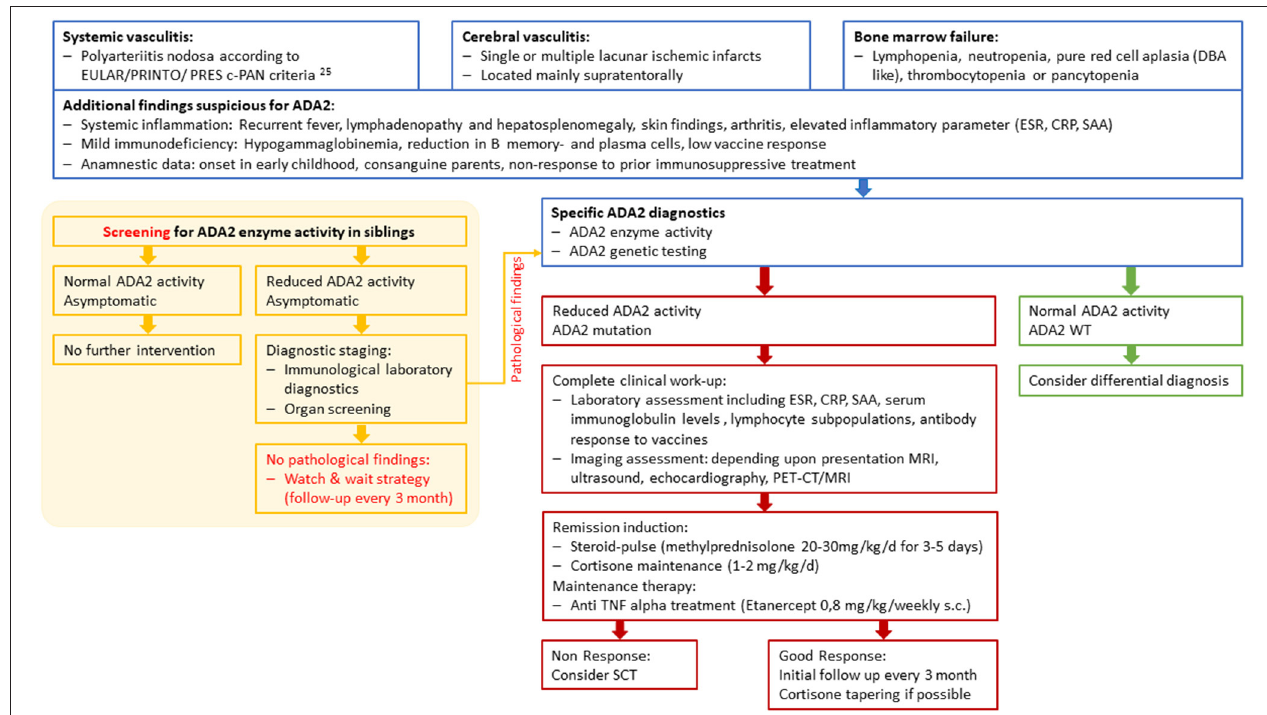
FIGURE 2 | Diagnostic and therapeutic workflow for ADA2 patients and siblings at risk. c-PAN, childhood polyarteriitis nodosa; DBA, Diamond-Blackfan anemia; ESR, erythrocyte sedimentation rate; CRP, C-Reactive Protein; SAA, Serum Amyloid A; WT, wild type; SCT, Stem cell transplantation.